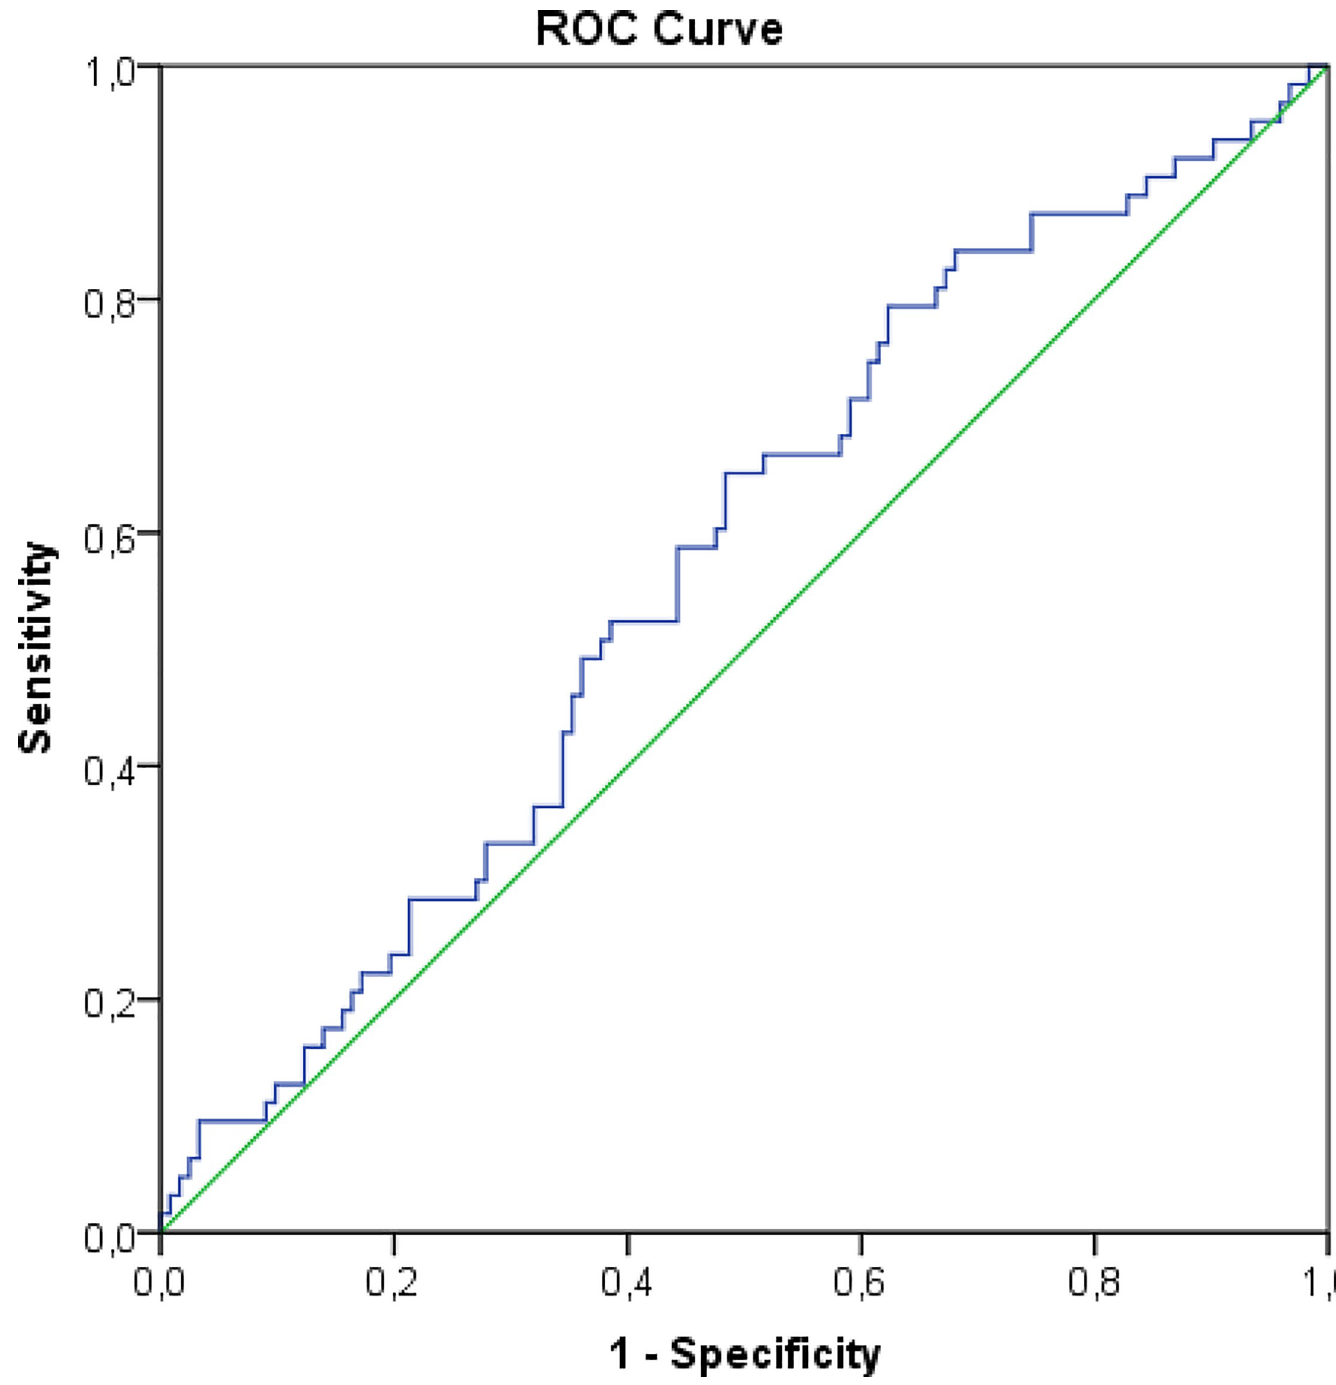
Fig 4. ROC curve between adjusted kidney volume and glomerular filtration rate (eGFR) after 1 year in deceased donors (curve area = 0.573, p = 0.1).